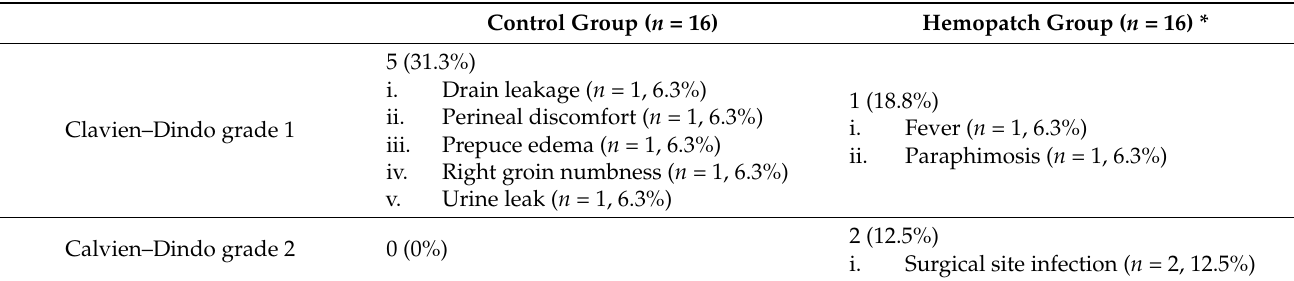
Table 3. Summary of 30-day